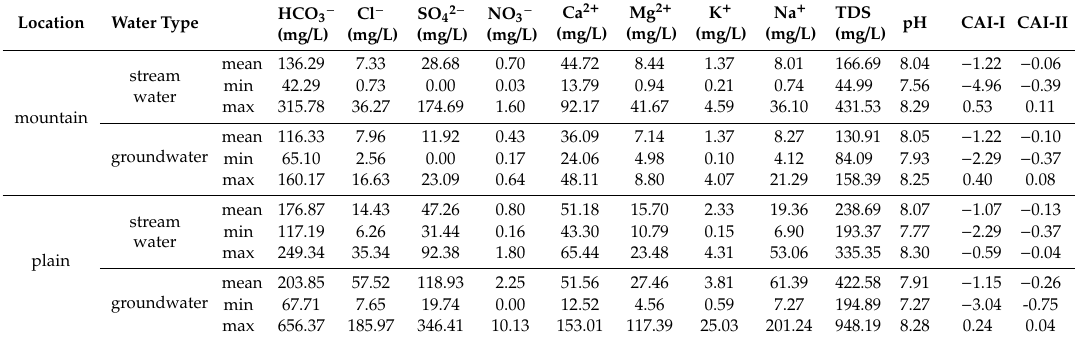
Figure 2. Spacial distributions of TDS and the major ions in plain groundwater. The unit is mg / L. Table 1. Statistics of the stream water and groundwater hydrochemistry and Schoeller The mean ion concentrations were the lowest in mountain groundwater and the highest in plain